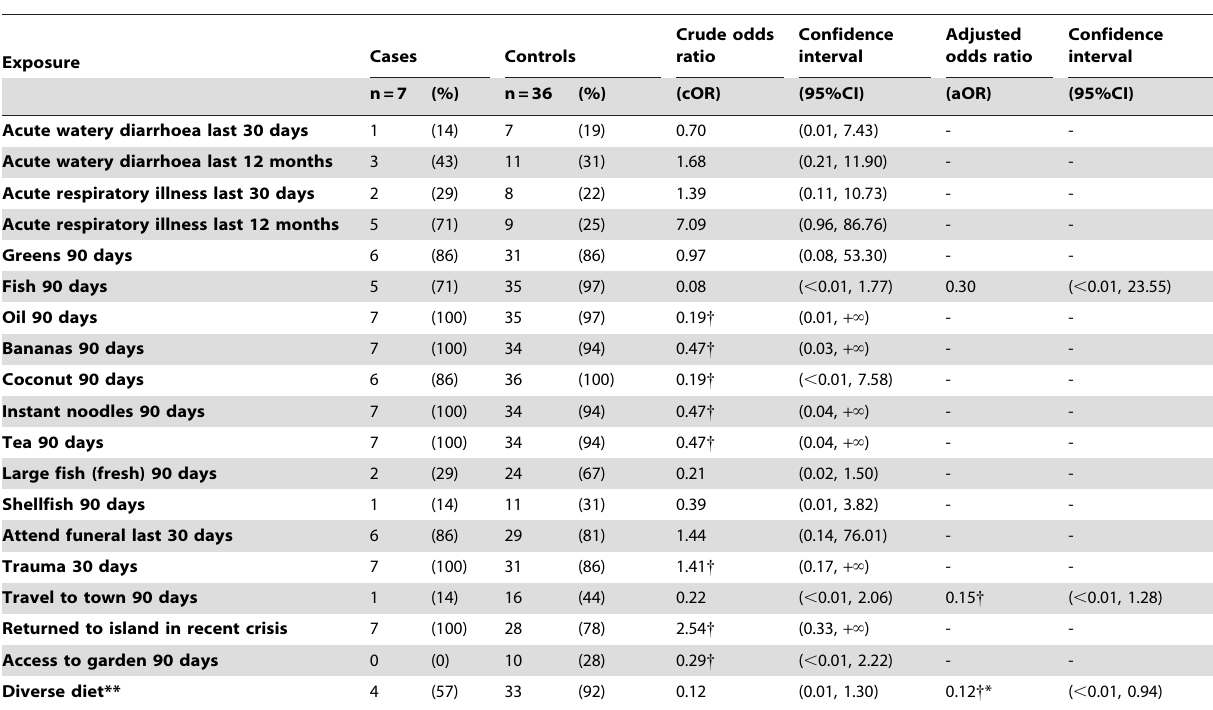
Table 2. Risk factors associated with peripheral neuropathy, Papua New Guinea, 2010.